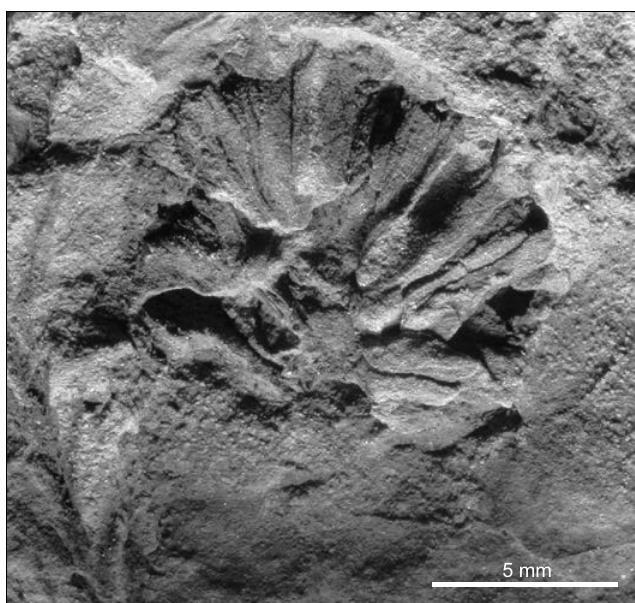
Fig. 6. Platanoid inflorescence Platananthus sp. from Żerkowice, North Sudetic Basin, Lower Silesia, Poland Assemblage 5 (upper Coniacian?– lower Santonian?). MB.Pb.2008/251a co-occurring with a Geinitzia twig (bottom